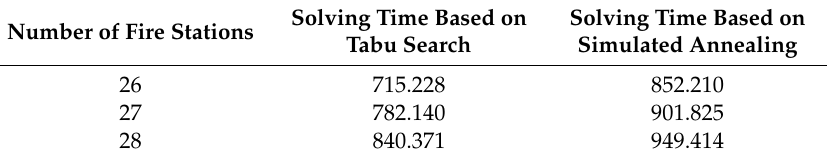
Table 26. Comparison of the average problem-solving time in